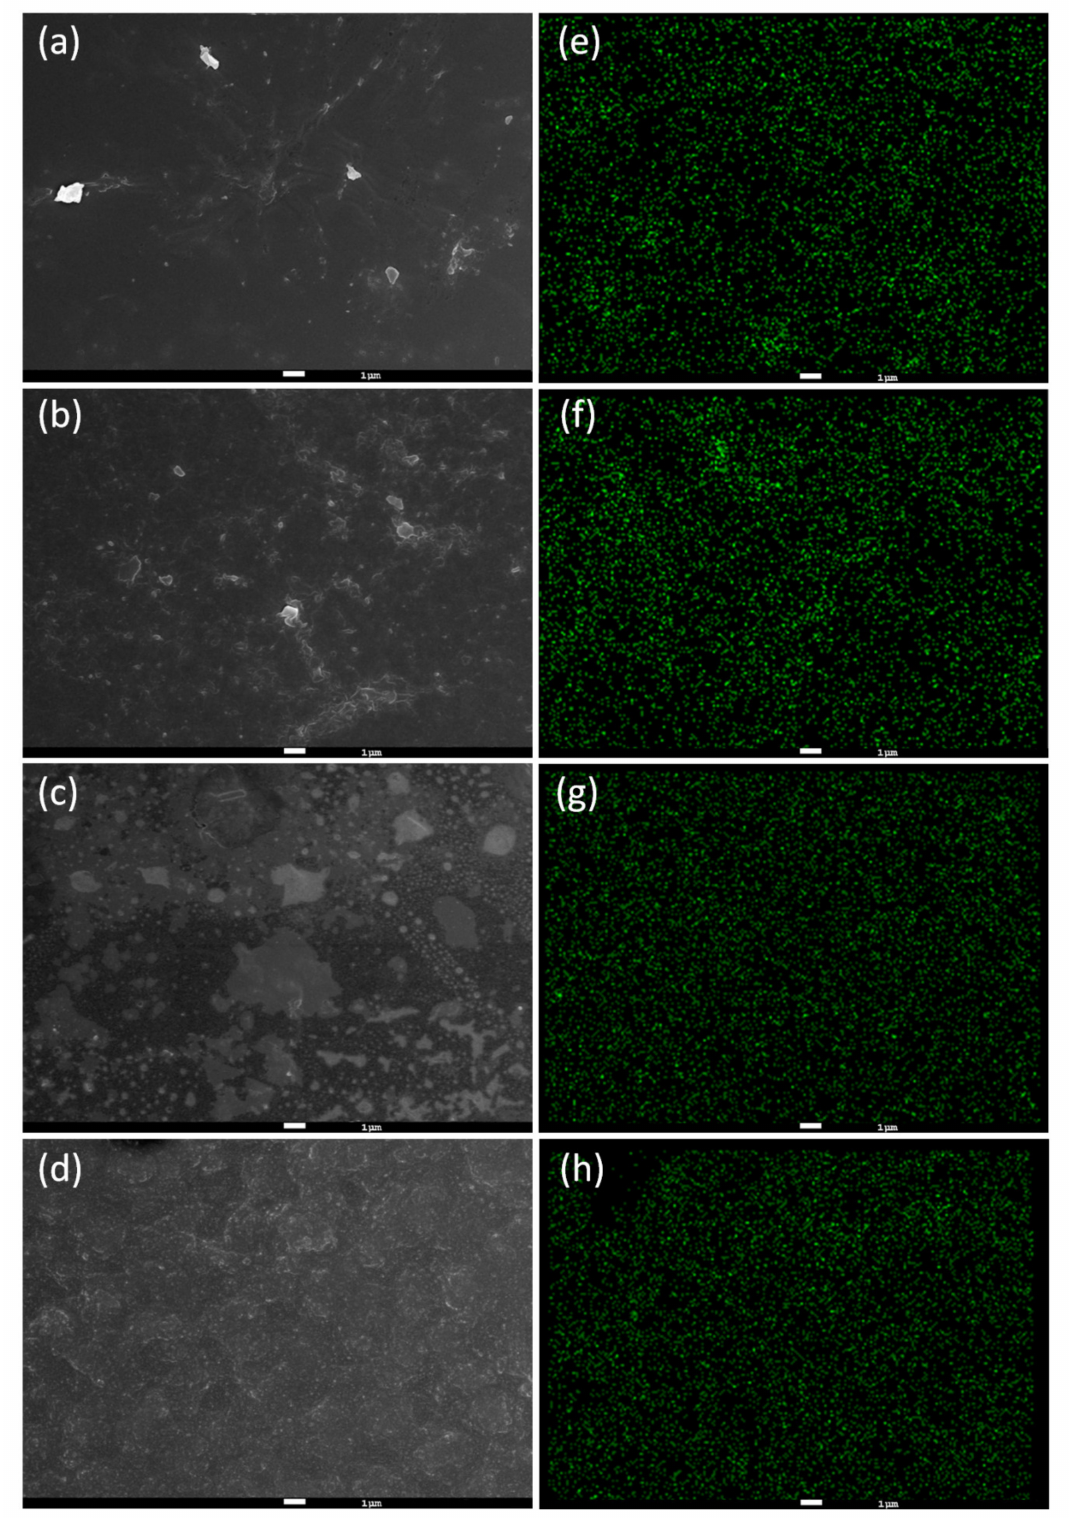
Figure7. SurfacemorphologyofZIF-8@PESpreparedusingdi ff erentmixingratiosathighmagnification. ( a – d ) SEM micrograph of 10, 20, 30, and 40 wt %, respectively, and ( e – h ) SEM-EDX of 10, 20, 30, and 40 wt %, respectively (Green: